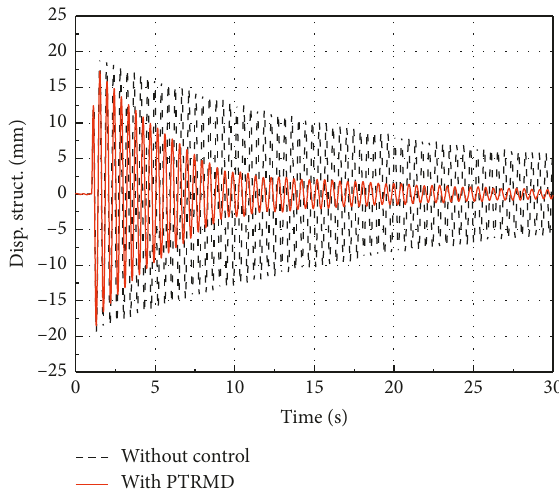
Figure 25: Displacement time history of dynamic response in free